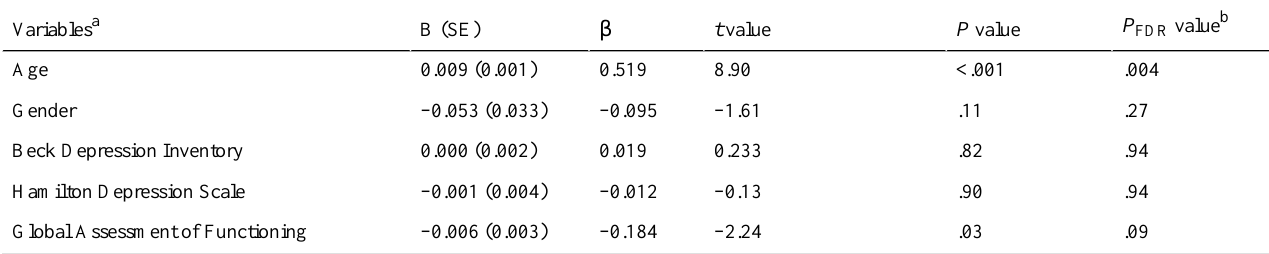
Table 2. Linear regression results predicting the effects of age, gender, and symptom severity on required time for data